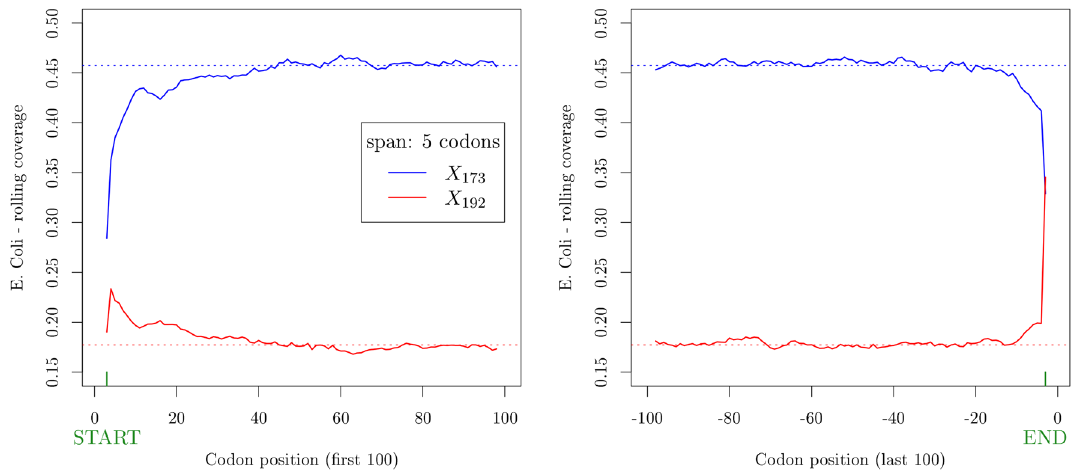
Figure 6. Rolling coverage (span: 5 codons) computed on the first (left) and last (right) 100 codon positions, averaged over the whole set of 3983 complete coding sequences of E. coli . The blue and red solid lines correspond to code X 173 and X 192 , respectively. The dotted lines correspond to the global coverage of the codes over the whole genome.